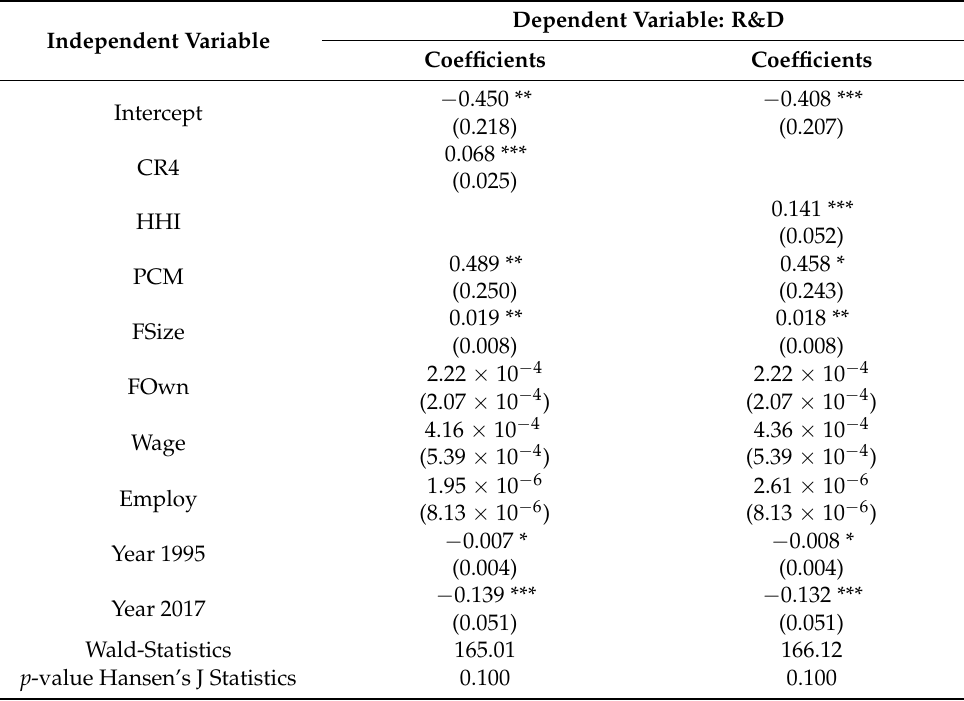
Table 3. Regression of industrial concentration and other variables on the